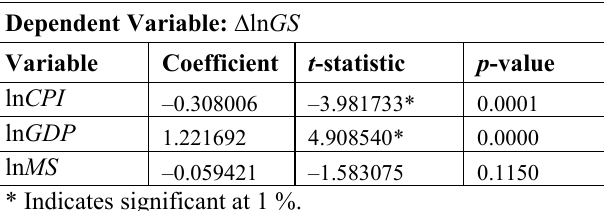
Table 6. Result of Long-Run Model Estimate